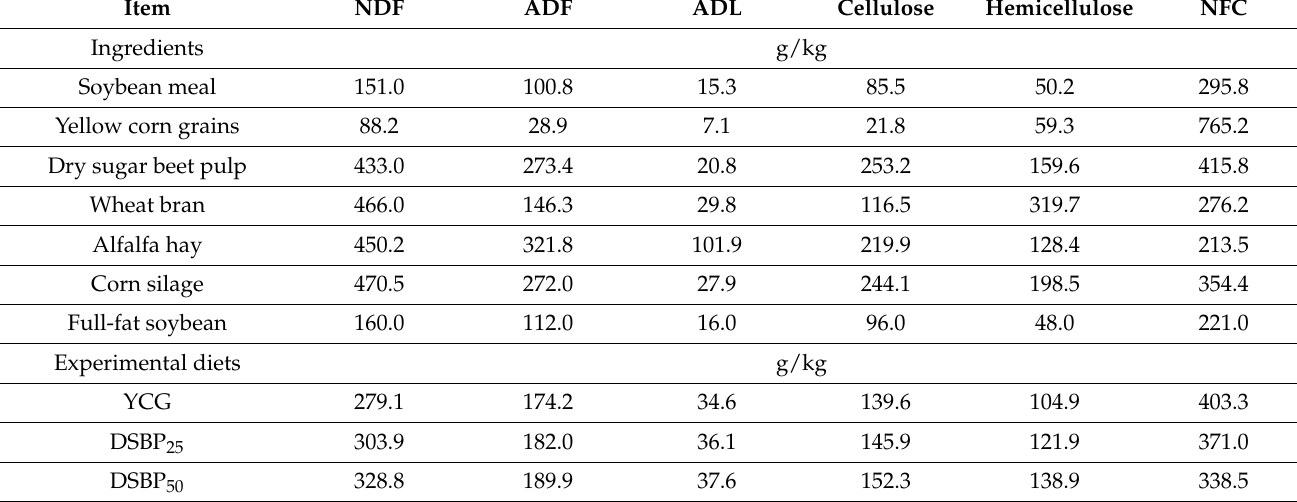
Table 3. Fiber fractions of ingredients and experimental